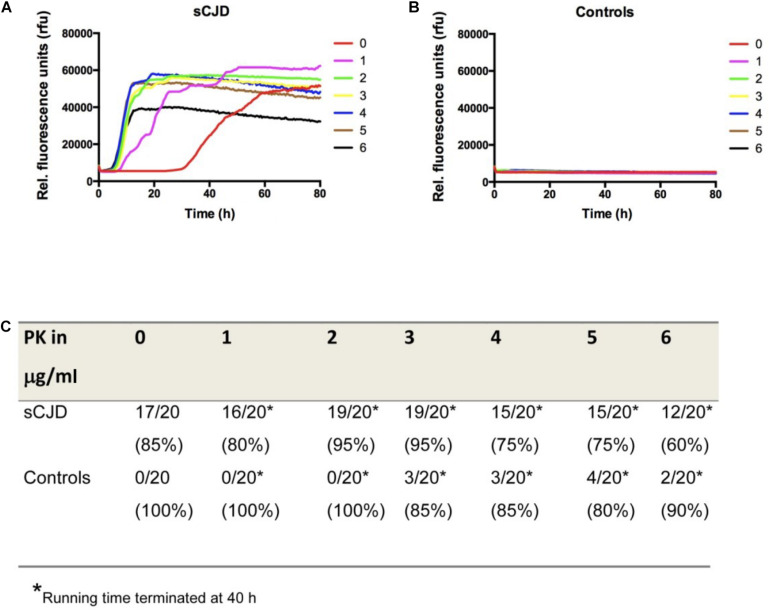
Influence of different amounts of PK on the RT-QuIC seeding response. (A,B) RT-QuIC reactions seeded either with sCJD MM or with control CSF were treated with different amounts of PK (0–6 μg/ml). The kinetics of positive RT-QuIC signaling responses indicated that treatment with PK influences the conversion efficiency of PrP in comparison to untreated reactions. (C) Accuracy of the RT-QuIC before and after PK treatment suggested a pre-treatment with 2 μg/ml PK as most suitable for a reliable diagnostic. For simplification, we displayed the means of all positive sCJD and negative control seeded reactions per group at each point in time and not the false-positive or -negative reactions.